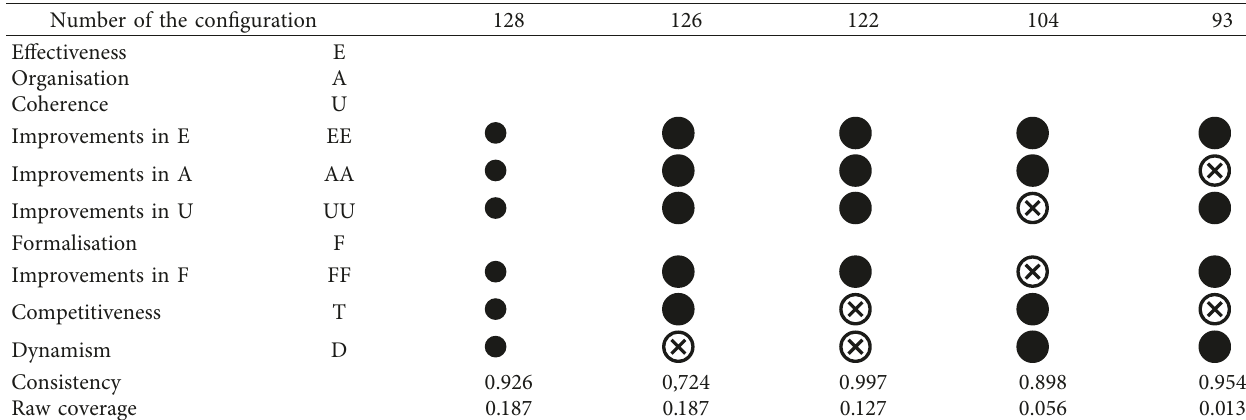
Table 6: The fuzzy sets